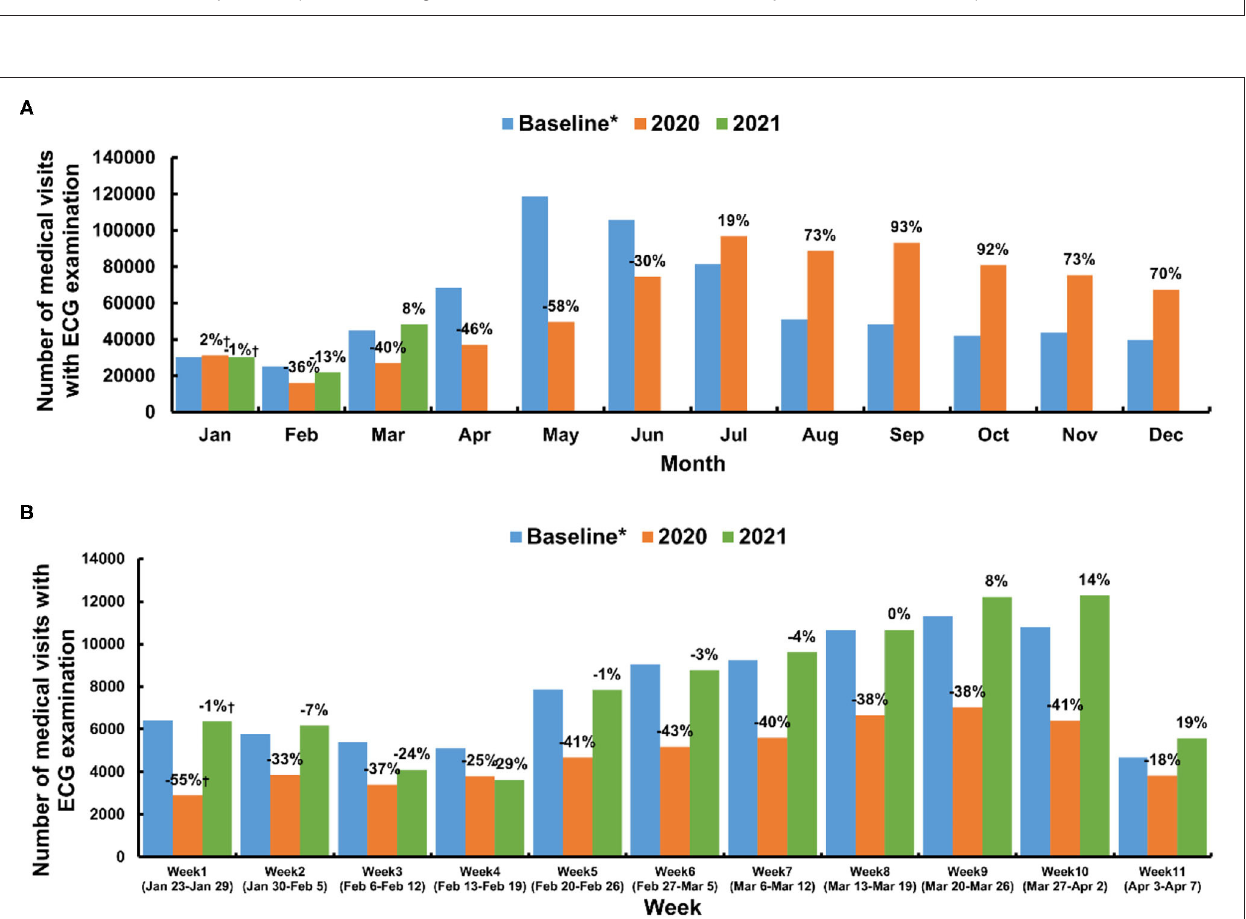
FIGURE 2 | Medical visits with ECG examination in Shanghai. (A) Monthly medical visits with ECG examinations of the baseline, 2020, and 2021. (B) Weekly medical visits during the lockdown (between January 23 and April 7, 2020) and the same period from the preceding years (baseline) and 2021. *Average number taken from 2018 and 2019. † The percentage difference compared with the baseline.